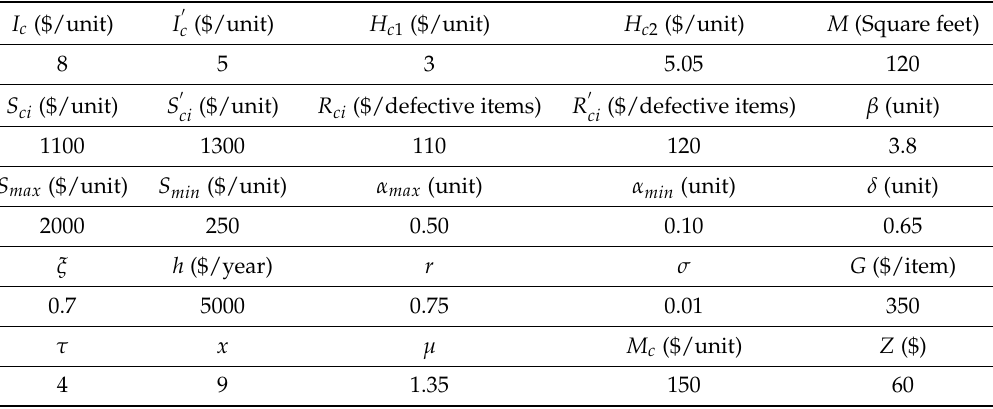
Table 4. Input parameters of Example 2.